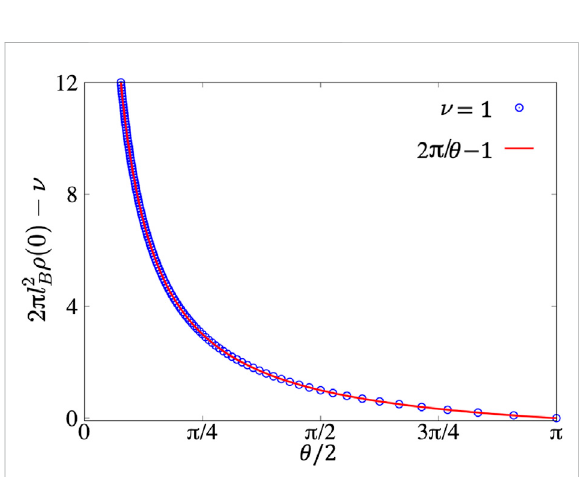
FIGURE 7 Accumulation of density at the tip for IQH state ρ (0). The data are perfectly fi tted by f ( θ ) = 2 π / θ −